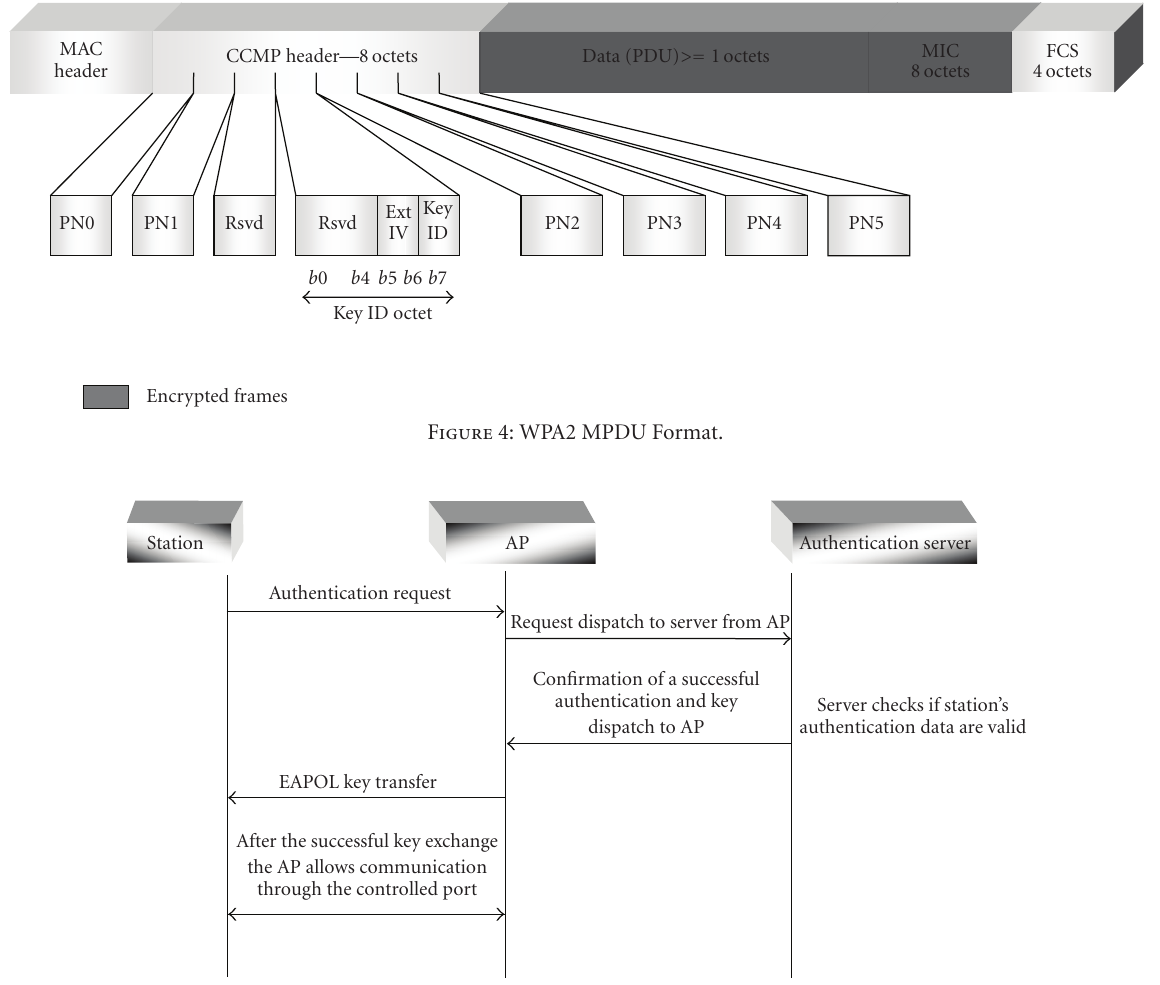
Figure 4: WPA2 MPDU Format.